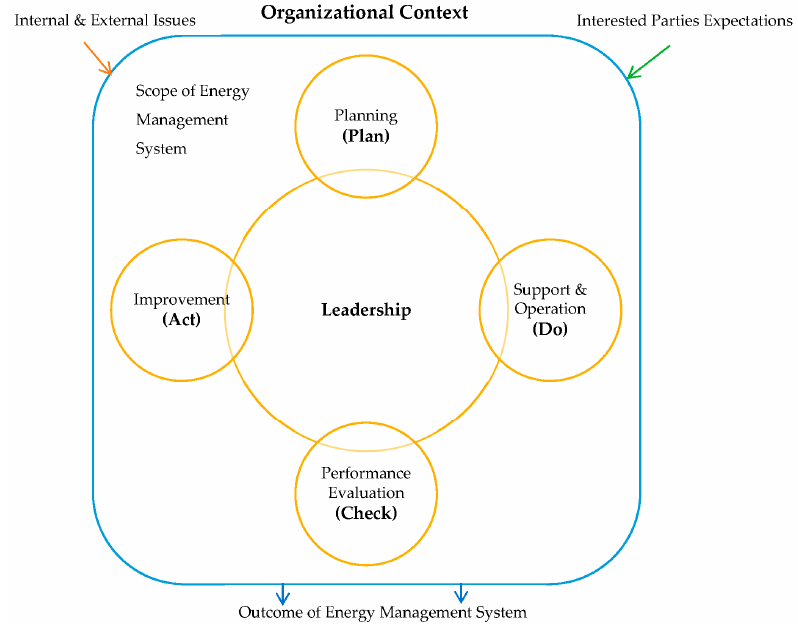
Figure 3. The “Plan-Do-Check-Act” cycle adopted in ISO 50001: 2018 (Source: [45]).